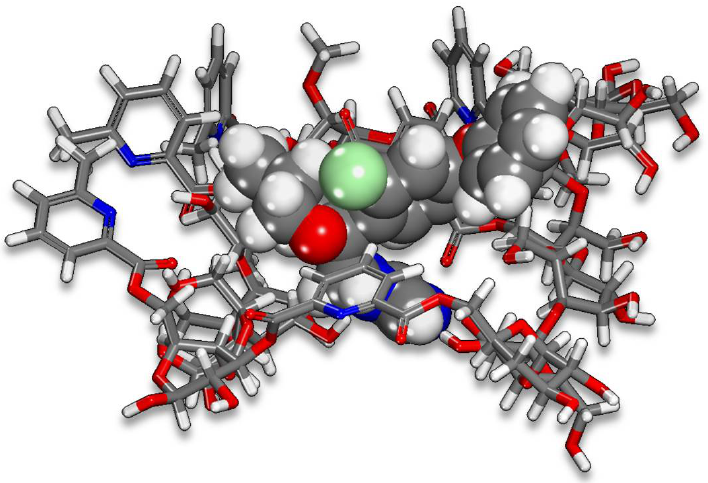
Figure 16. MC pose of the lowest adsorption configurations for the difenoconazole molecule onto the Cell-X surface.